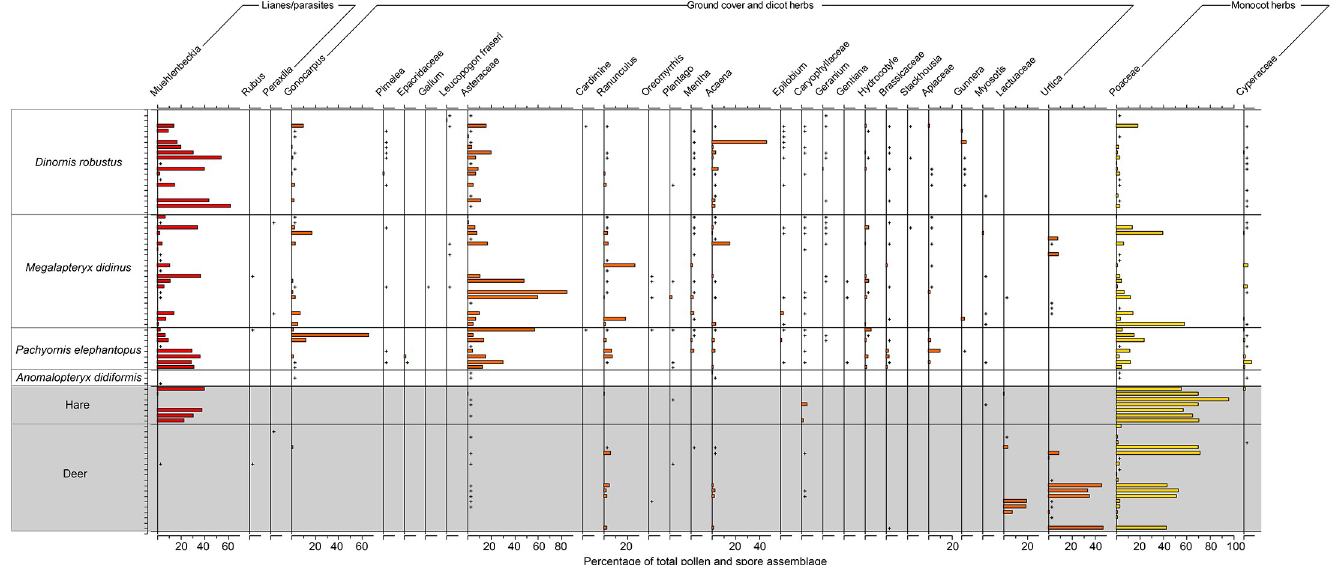
Fig 6. Pollen diagram showing lianes, parasite, ground cover and herbaceous pollen types. Moa coprolites and mammal pellets from Daley’s Flat rock avalanche deposit. Rare pollen types ( < 1% total pollen assemblage) are represented by + symbols.